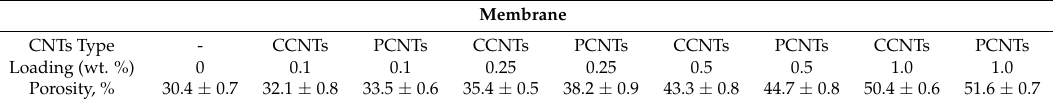
Figure 4. Water fluxes of PS and PS/CNTs nanocomposite membranes at different CNTs loading versus operating pressure. Table 2. Total porosity of PS/CNTs nanocomposite membranes.